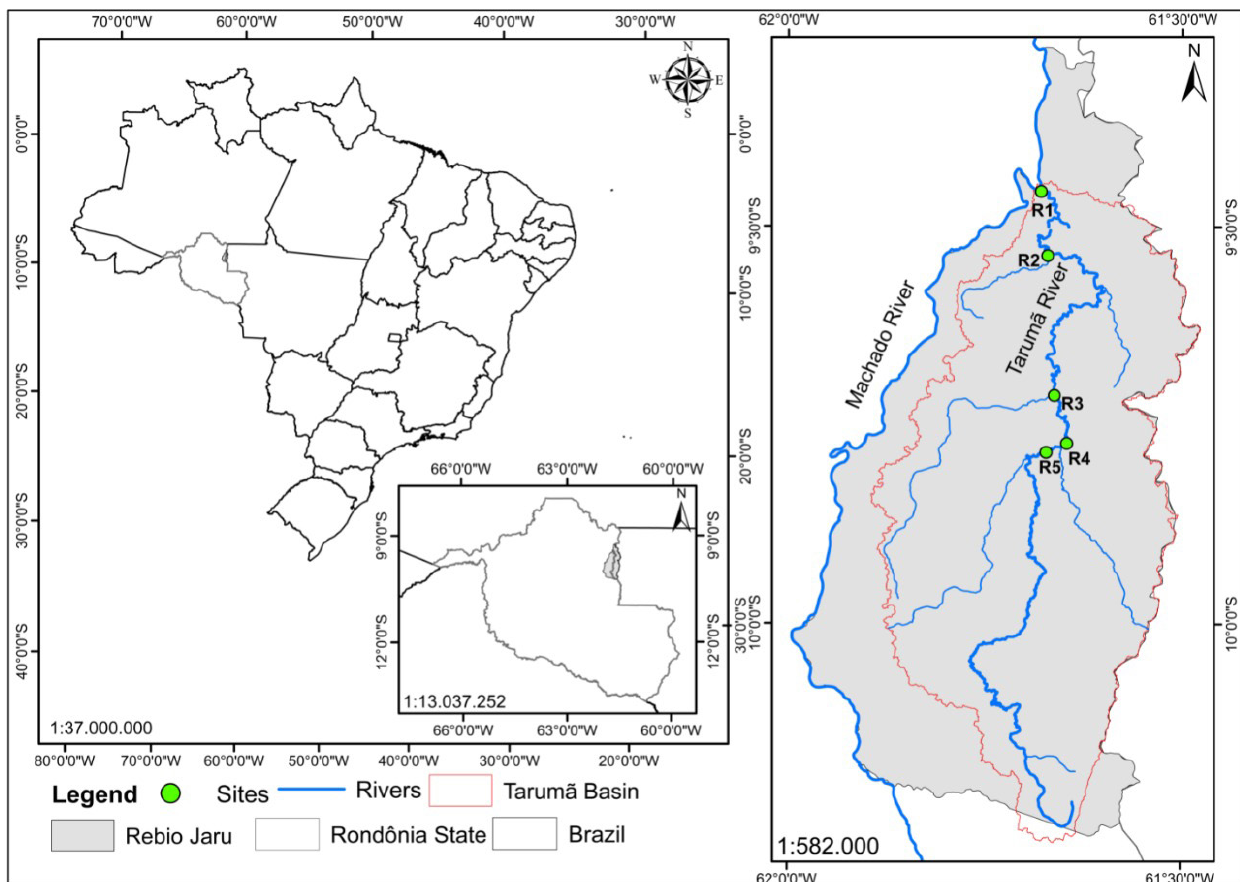
FIGURE 1 | Map of the study area showing the collection stations in the drainage systems in the Jaru Biological Reserve (shaded area), Rondônia, Brazil. Circles represent collection points in the river channels of the Tarumã